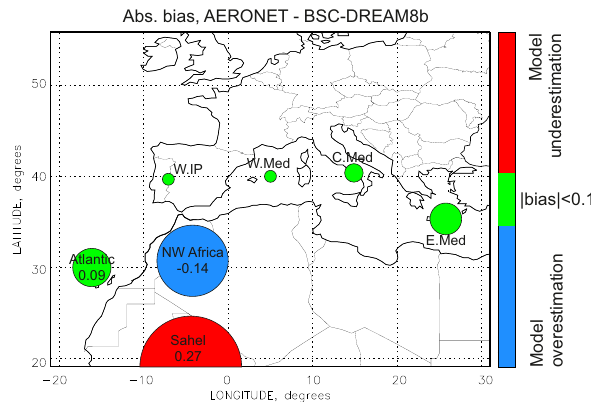
Fig. 11. Spatial distribution of AOD model absolute biases from the BSCDREAM8b evaluation against AERONET (Basart et al., 2012).